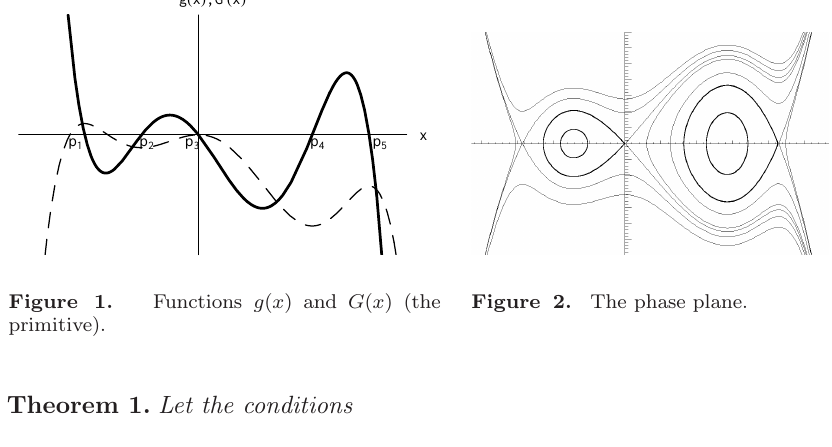
Figure 2. The phase plane.